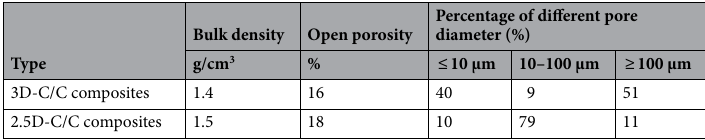
Table 1. Pore characteristics of C/C composites from mercury injection.